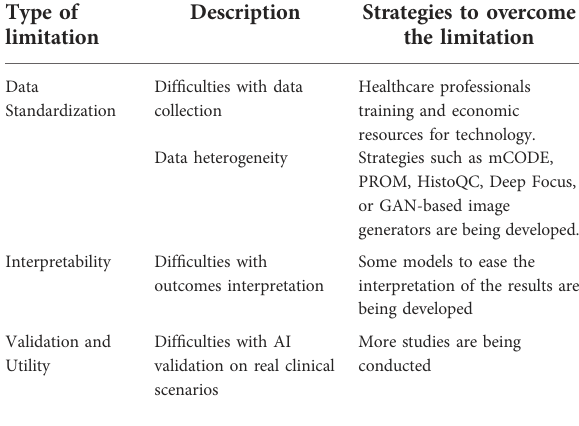
TABLE 1 Limitations for AI in cancer care in